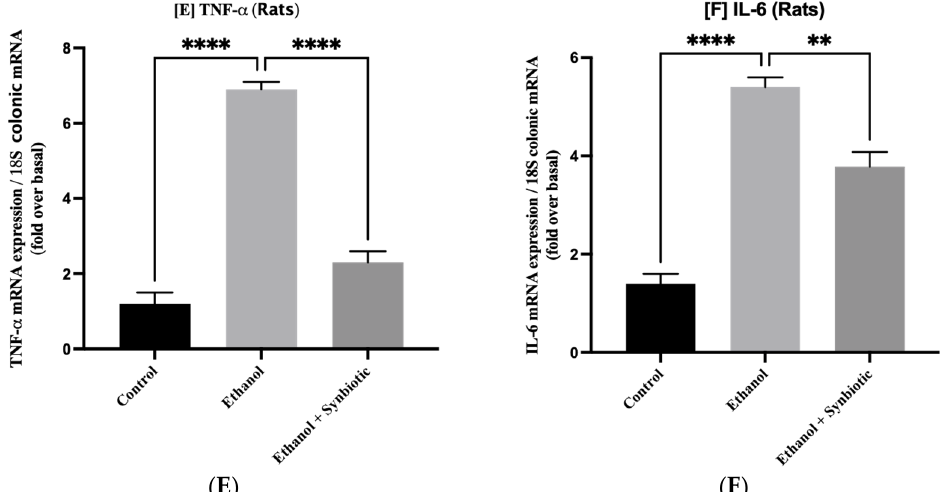
Figure 7. Synbiotic (AGE + L. rhamnosus MTCC 1423) mRNA expression on ethanol-induced gut dysbiosis. Expression of ( A ) ZO-1 and ( B ) occludin, ( C ) anti-inflammatory biomarker HO-1 as well as inflammatory biomarkers ( D ) CYP2E1, ( E ) TNF-a, and ( F ) IL-6. The statistical analysis was calculated as mentioned in Section 2.10. Mean − /+ SD was determined for N = 6 replicates. For statistical analysis, GraphPad Prism 7 and one-way ANOVA in conjunction with the Tukey post hoc test were calculated. When associated with the ethanol group, significance ( p -value) is defined as * p < 0.05, ** p < 0.01, *** p < 0.001, **** p < 0.0001.